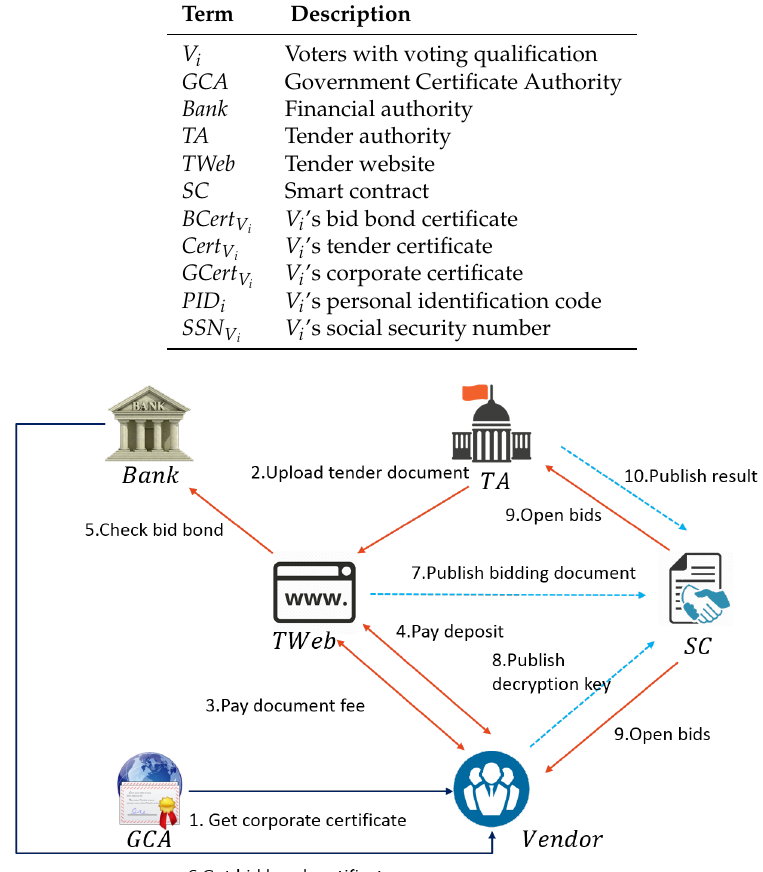
Figure 5. Architecture of our E-bidding